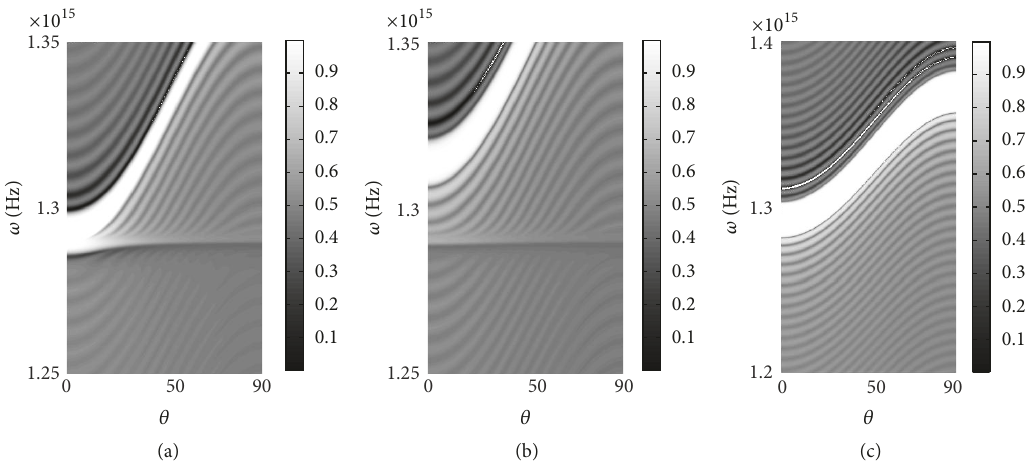
Figure 4: Black areas are band-gaps of photonic crystals containing 200-periodic (a) InGaAs/InP, (b) InGaAs/GaAs, and (c) InAlAs/InP QWs without implementing an external pump